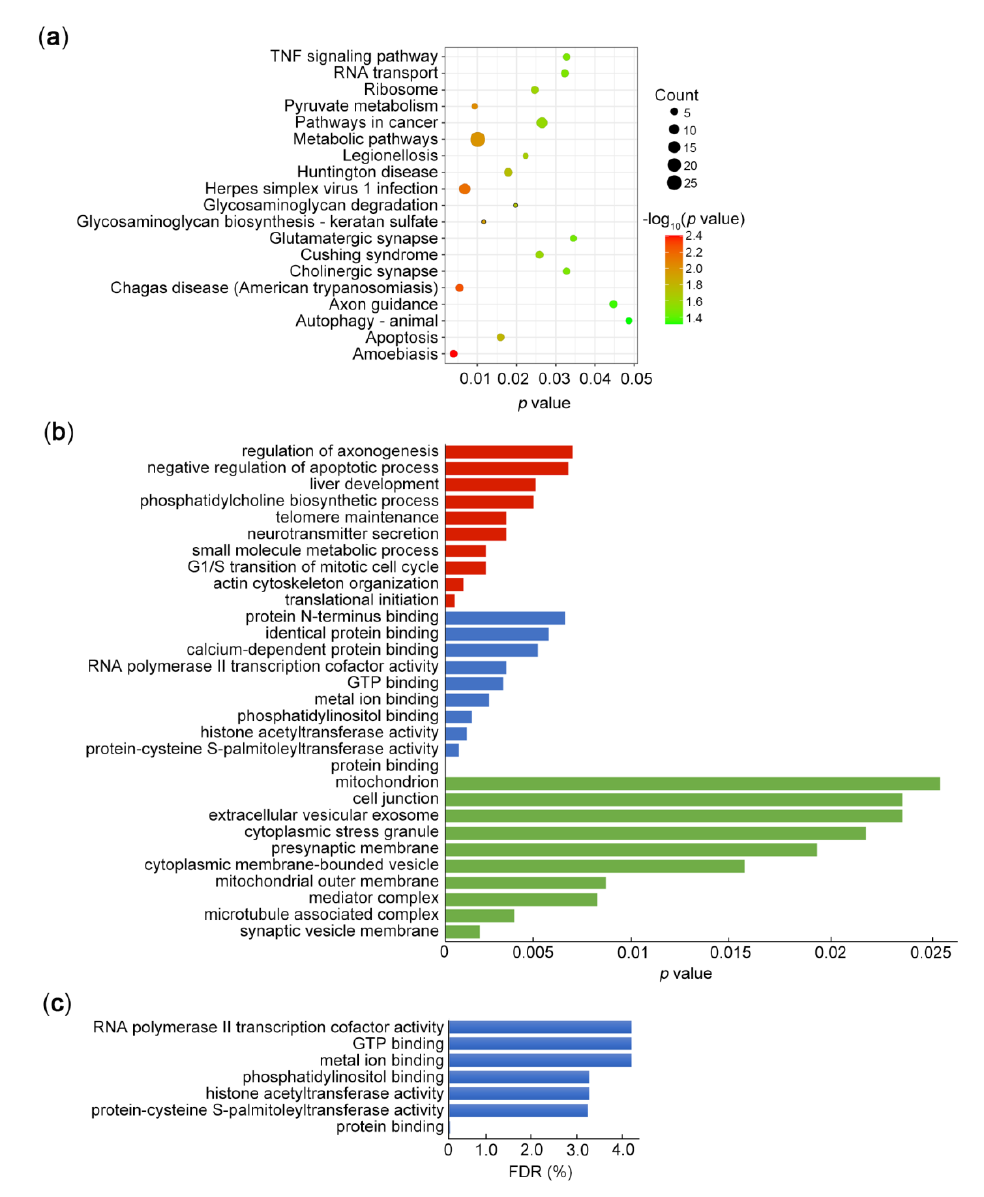
Figure 2. KEGG and GO analysis of ChIP-seq. ( a ) The significantly enriched KEGG pathways are shown based on ChIP-seq data in KYSE510 cells after PURα overexpression ( p < 0.05). ( b ) The top 10 enriched biological process (BP), cellular component (CC) and molecular function (MF) of the same ChIP-seq data via GO analysis ( p < 0.05, the red, blue and green bars refer to CC, BP and MF, respectively). ( c ) GO analysis of ChIP-seq via FDR correction shown the top 7 enriched BP functions ( p < 0.05, FDR < 5%).